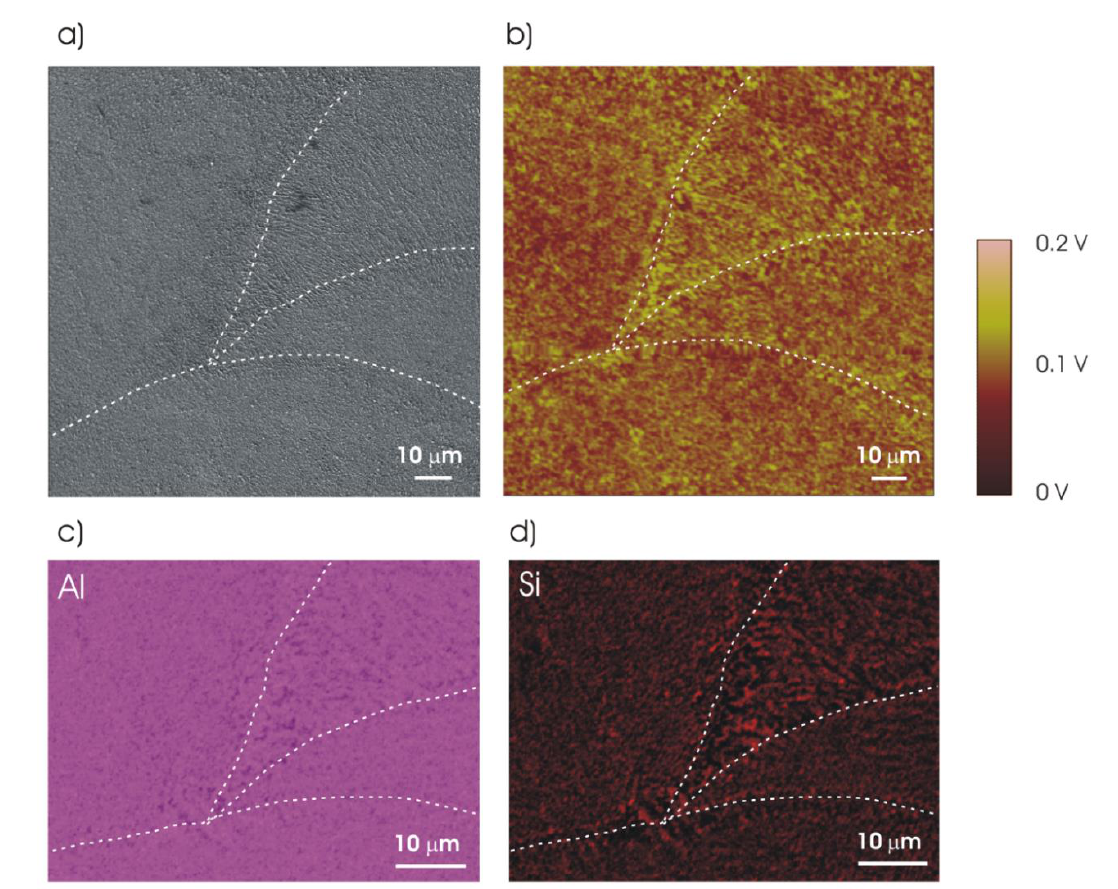
Figure 5. ( a ) Scanning electron microscopy (SEM) micrograph without metallographic attack, ( b ) SKPFM Volta potential map of the same region shown in the SEM micrograph and ( c , d ) energy-dispersive X-ray spectroscopy (EDS) elemental maps of Al and Si of the 2h-300 specimen. The melt pool edges are highlighted with dashed lines. (XZ specimens).